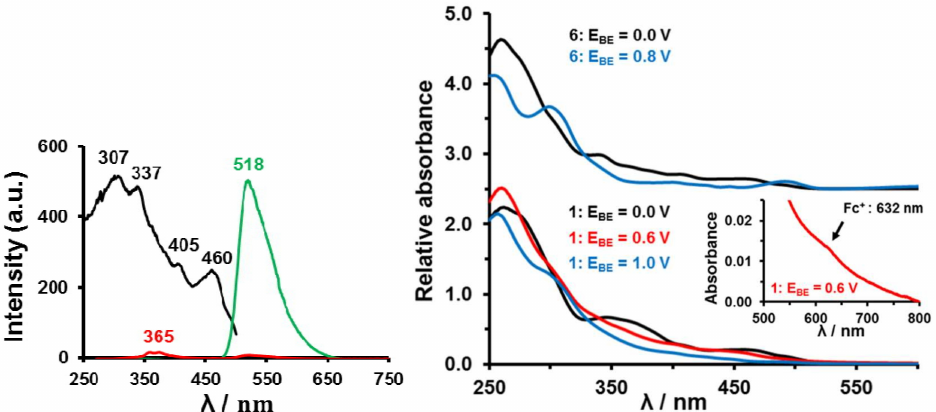
Figure 8. Left: Excitation spectrum (black) for observing emission at 518 nm and photoluminescence spectra (green and red) at 20 o C of a CH 2 Cl 2 solution containing 0.050 mmol dm -3 [(ppy) 2 Ir(acac)], 6 , and 0.05 mol dm -3 [N( n Bu) 4 ][PF 6 ], before (green) and after (red) bulk electrolysis at 0.8 V vs. Ag wire. After bulk electrolysis, Ir III was converted to Ir IV , but the same excitation caused hardly any emission (red spectrum). Right: UV–Vis spectra of 0.05 mmol · dm − 3 CH 2 Cl 2 solutions of [(ppy) 2 Ir(acac)], 6 , (top) and [(ppy) 2 Ir(FcCOCHCOCH 3 )], 1 , (bottom) in CH 2 Cl 2 in the presence of 0.05 mol · dm − 3 [N( n Bu) 4 ][PF 6 ] at 20 o C after bulk electrolysis (BE) at the indicated potentials (E BE vs. Ag / Ag + ). Black spectra are for 1 and 6 in the ground state. The red spectrum was obtained after Fc oxidation in 1 to generate 1 + ; blue spectra are the result of Ir III oxidation generating 1 2 + or 6 + . The red insert highlights an electronic band associated with the Fc + moiety of 1 +